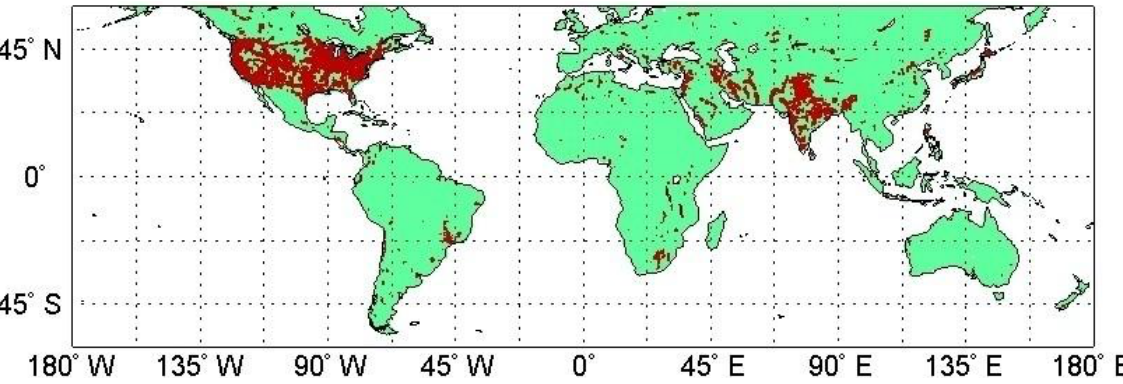
Fig. 1. The green areas indicate the areas where C-band observations are used. The red areas indicate where C-band observations are contaminated by RFI and X-band observations are used.